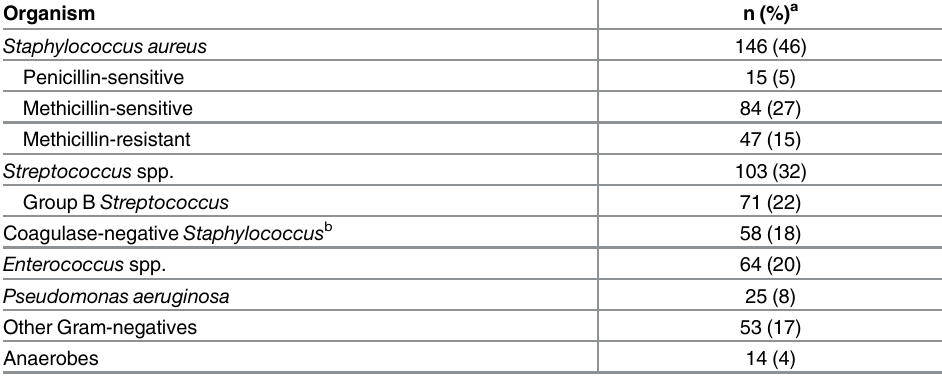
Table 3. Causative pathogens among culture-positive DFI patients, n =